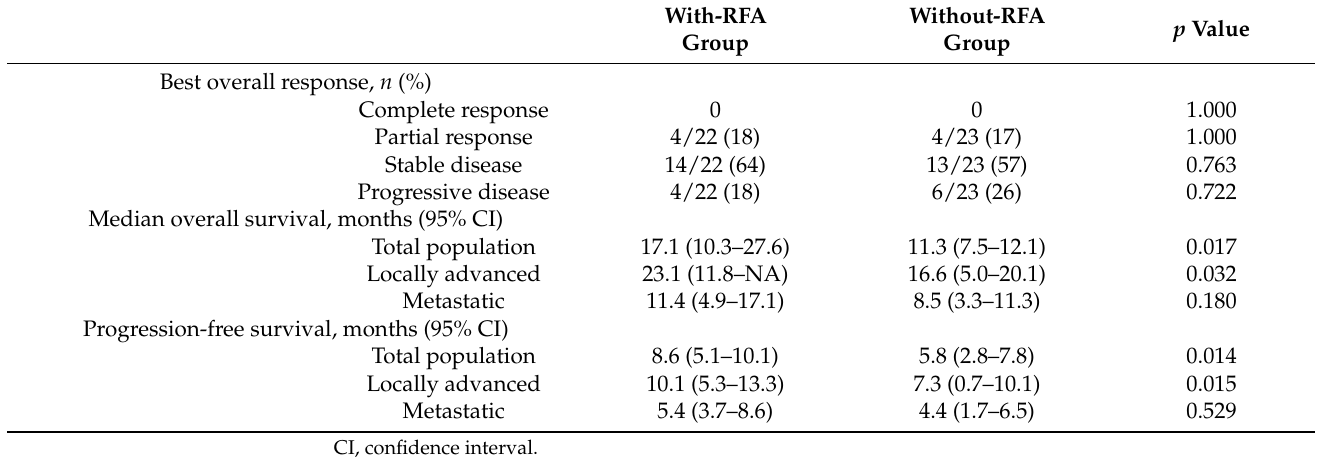
Table 3. Efficacy of gemcitabine plus cisplatin chemotherapy with/without radiofrequency ablation.